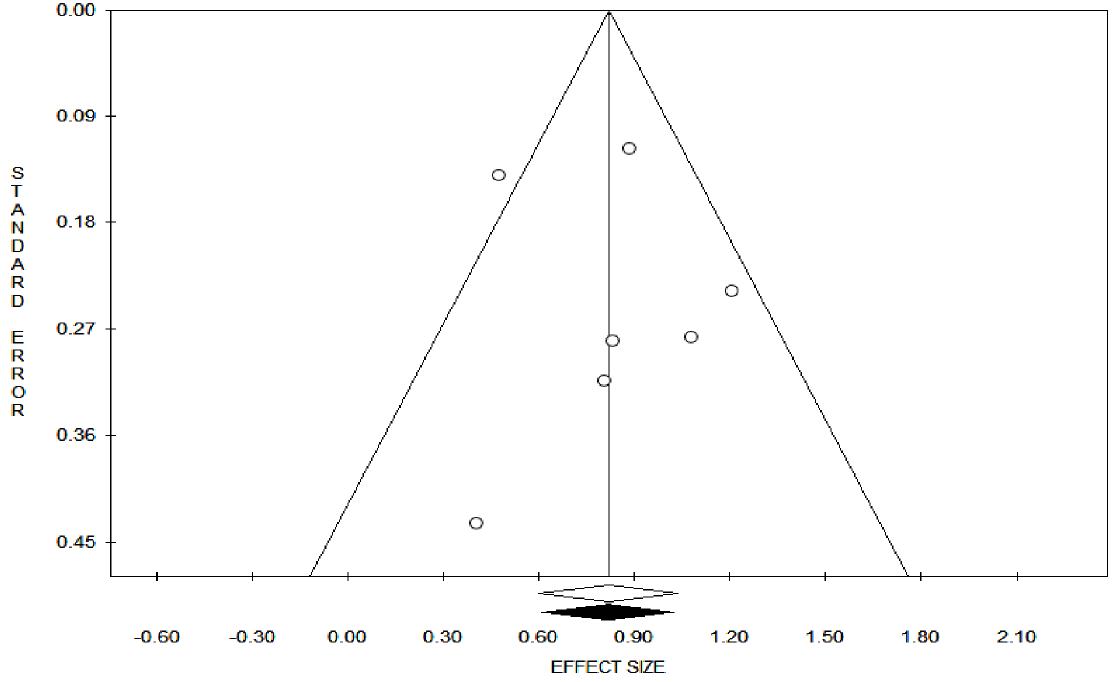
Fig 5. Funnel plot on geographic access to obstetric care facility within